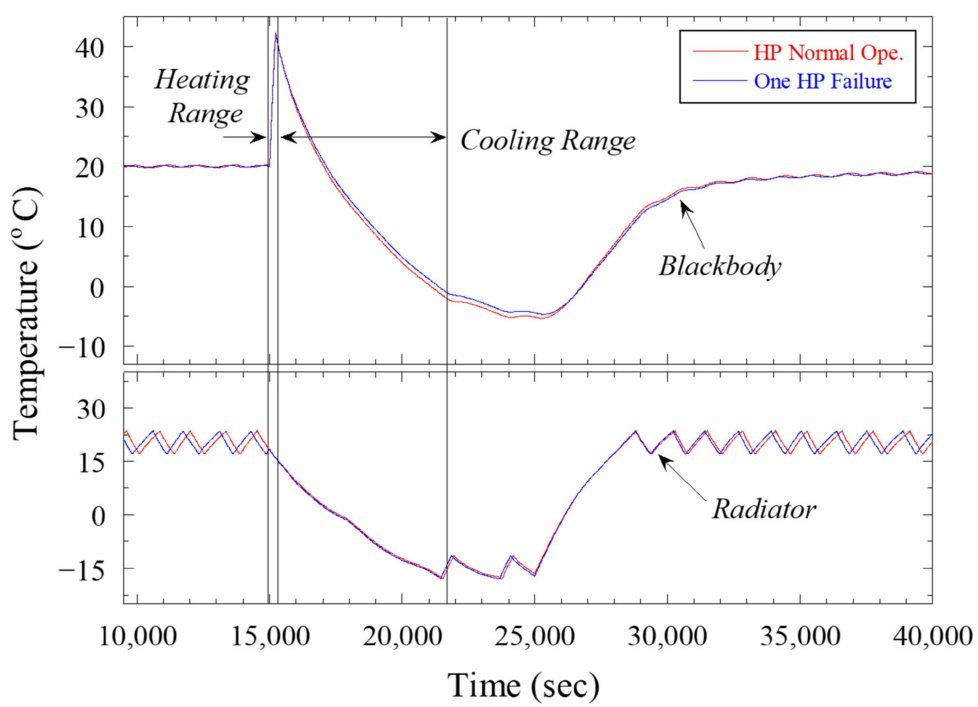
Figure 9. Temperature profile on BB surface and radiator with one heat pipe failure case in the worst hot case.